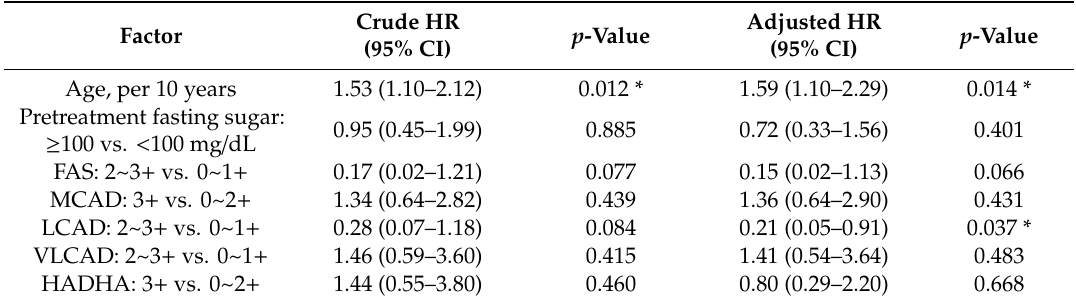
Table 6. Crude and adjusted HRs with 95% CIs for mortality related to clinical parameters and fatty acid oxidation-related expression of enzymes. Stage III / IV case ( n =